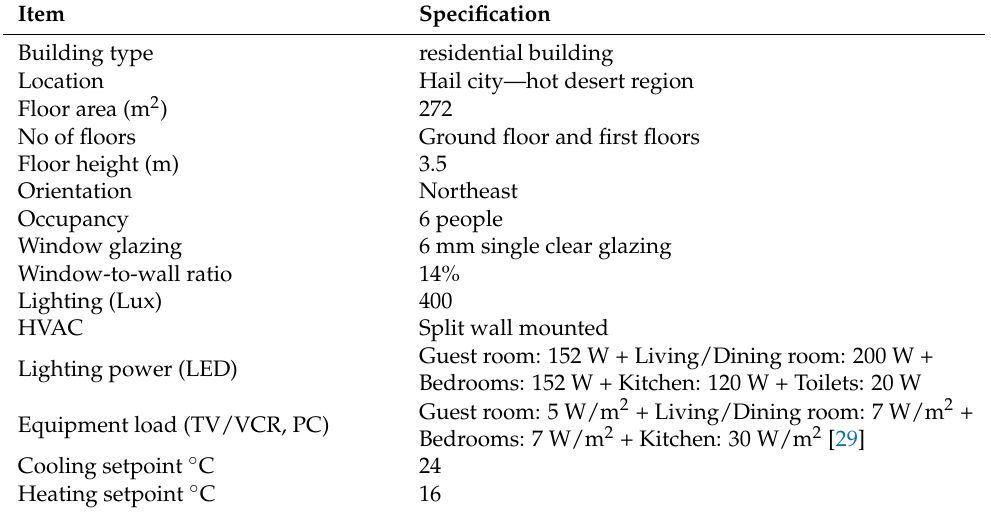
Table 2. Principal input and characterization of building simulation